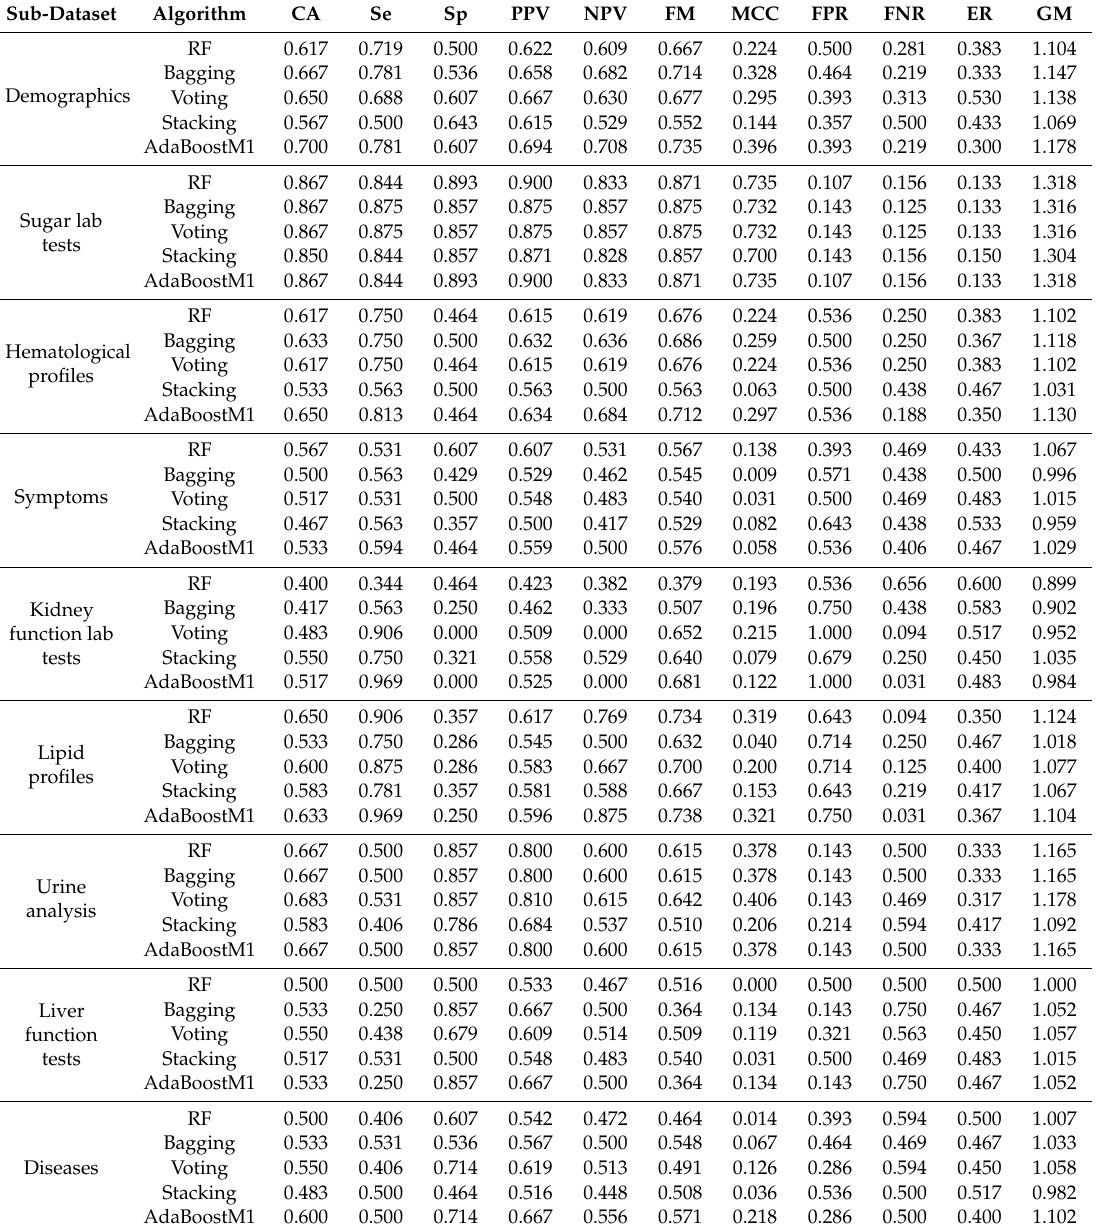
Table 5. Classification results for ensemble classifiers with correlation-based feature